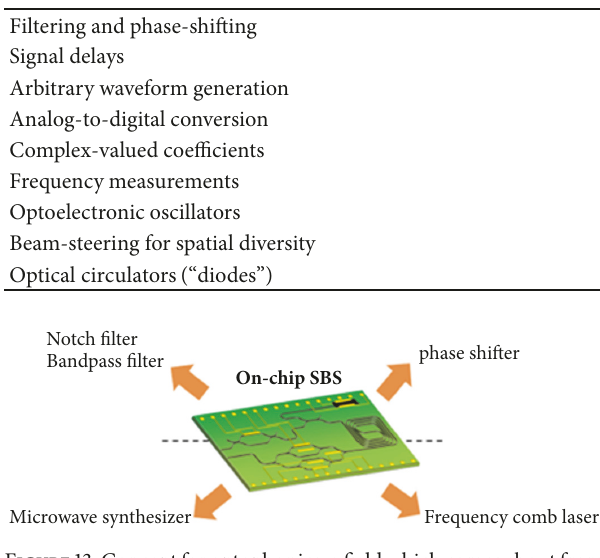
Table 1: Optophonic circuit applications.